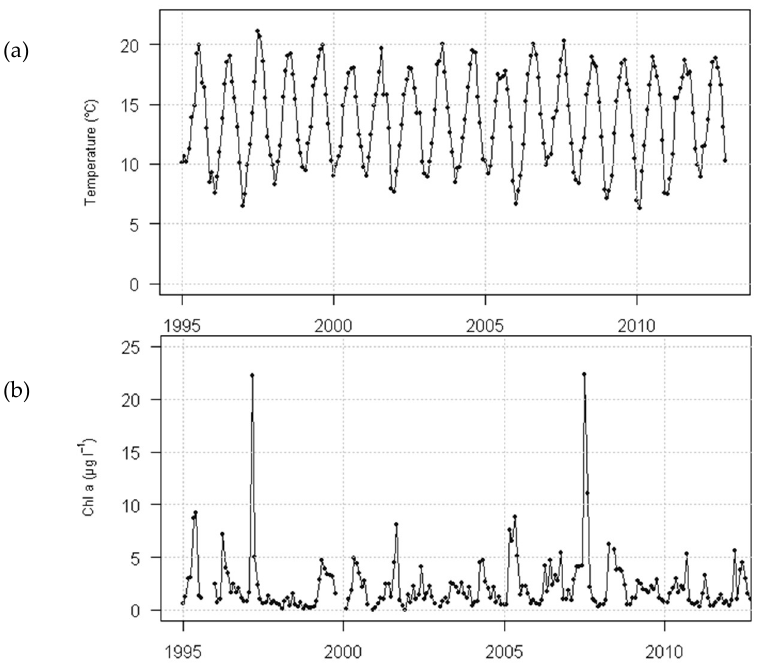
Figure 2. Inter-annual variations (1996–2012) of water temperature (°C) ( a ), and chlorophyll-a ( Chl. a , µg·L −1 ) ( b ), at Le Croisic sampling station (Loire-Atlantique, France). Data from Ifremer/Quadrige/Rephy © .